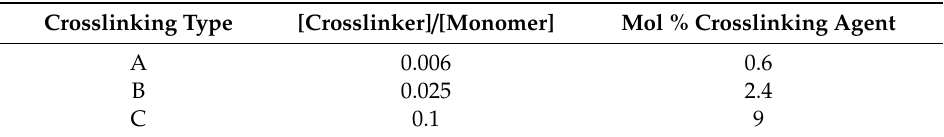
Table 1. Summary of three different crosslinking types.